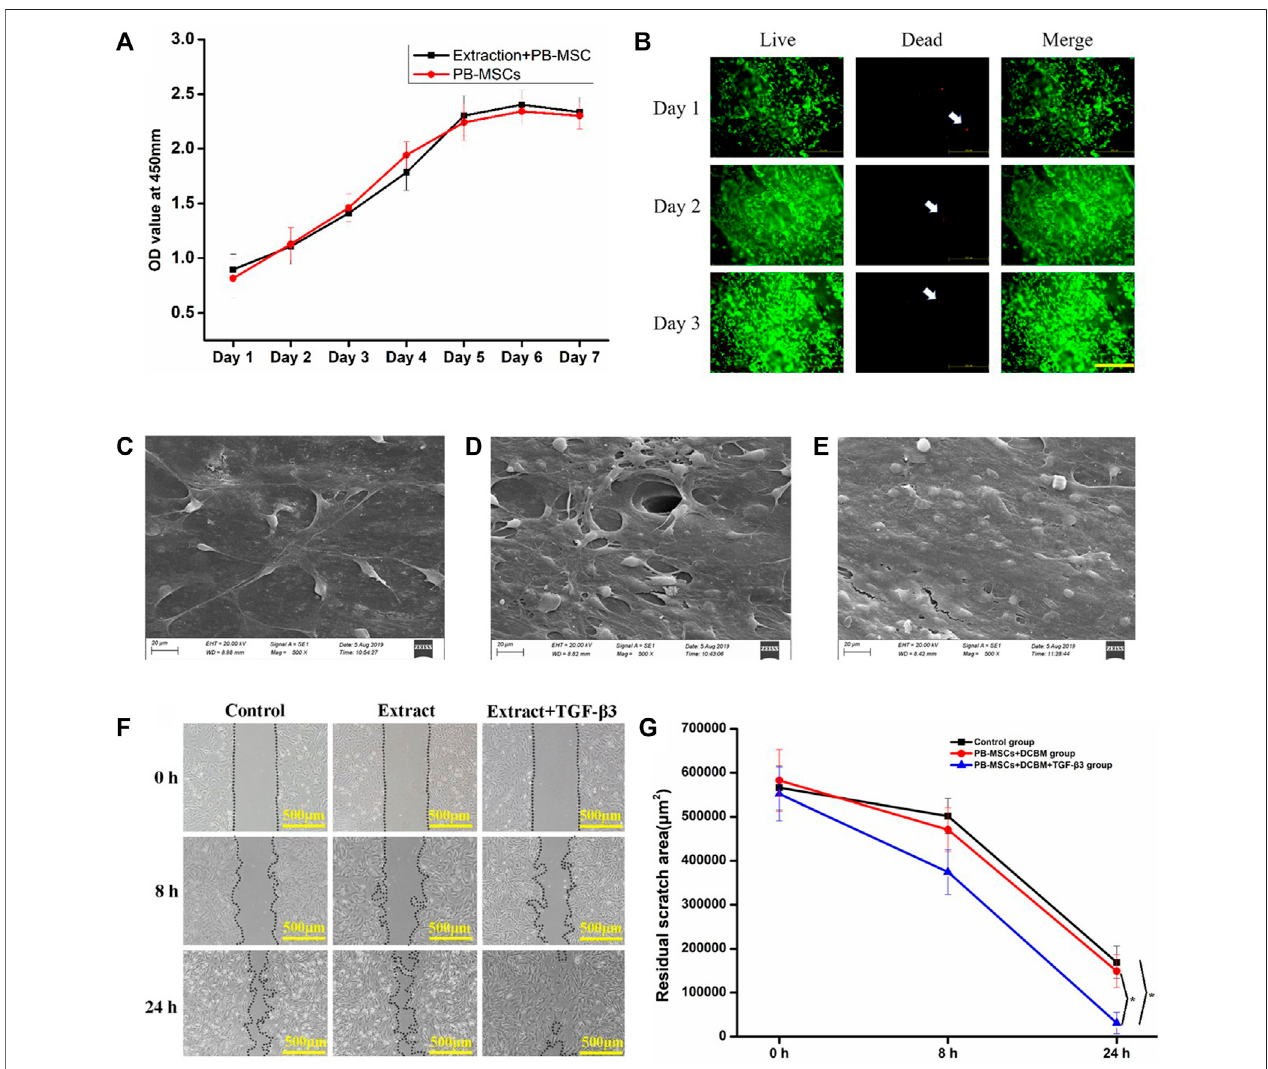
FIGURE4| InteractionofPBMSCsandDCBM. (A) comparisonofcellproliferationabilityinDCBMextractgroupandcontrolgroup; (B) Live/Deadstaininganalysis of PBMSCs seeded on DCBM. Green represented live cells while red represented dead cells. White arrow pointed the dead cells. Scale bar: 500 μ m; the surface ultrastructure of DCBM scaffolds seeded with PBMSCs in (C) 1st, (D) 2nd and (E) 3rd day; (F) remaining area at different time points after scratching; (G) quantitative analysis of remaining area from different groups. * p < 0.05.